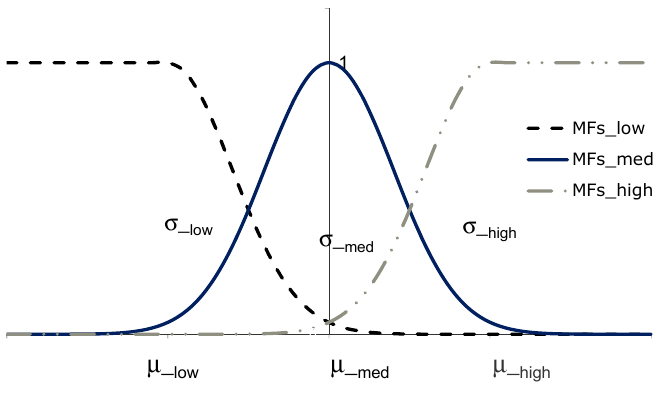
Figure 5. Gaussian membership functions